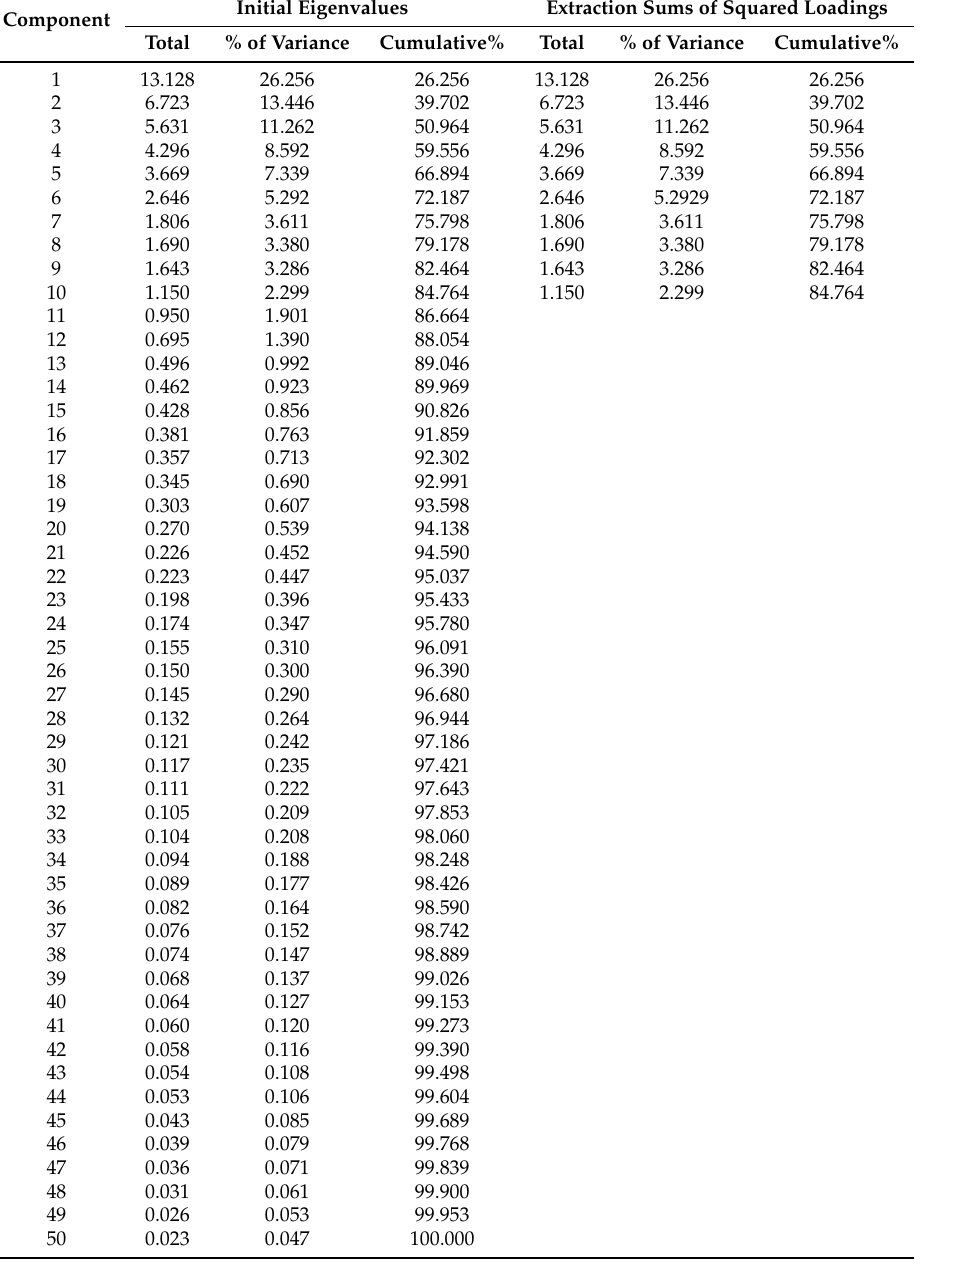
Table 13. Total variance explained (extraction method: principal component analysis).